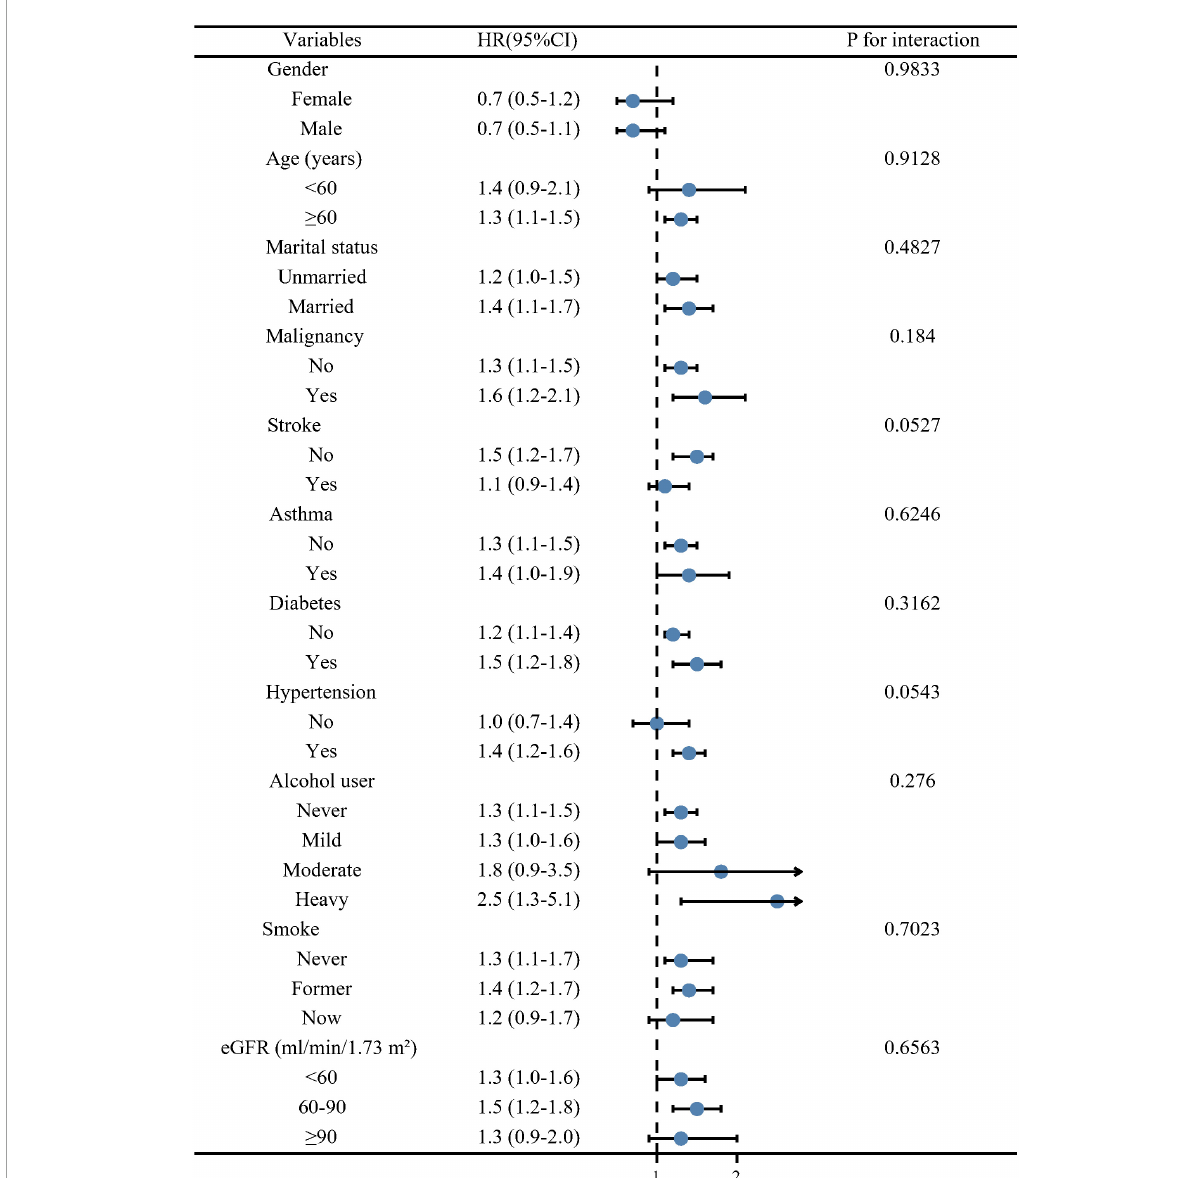
FIGURE3 Forest plot of subgroup analysis for all-cause mortality. Hazard ratios (HRs) were calculated using multivariate Cox regression models adjusted for the variables listed in the fully adjusted model except for the variable used for stratification.